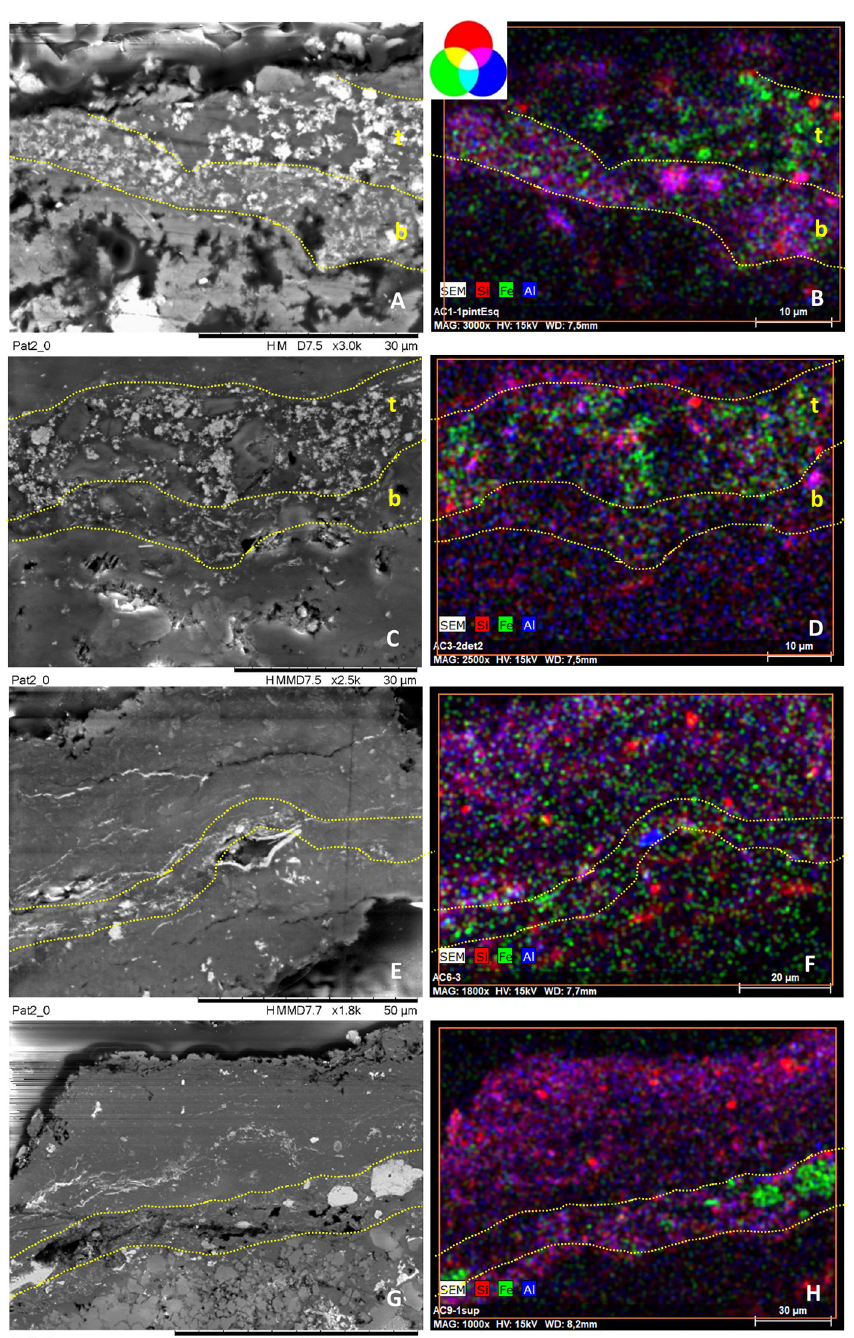
Fig 9. SEM backscattered images and their RGB composite images of the elemental distribution of Si K α /Fe K α /Al K α of a selected area of cross-sections AC1 (images A-B), AC3 (images C-D), AC6 (images E-F), AC9 (images G-H) constitutive of group 3. See S1 Figs 6–8 in S1 File to visualize the location of the analyzed areas (framed by red squares). the investigated paint layers. If we focus on samples AC1 the superimpositions of motifs 6, 7, and 9 and 5 and 6 respectively, they have in common motif 6, the orange-like zoomorphic motifs. In both samples, the bottommost stratum laying